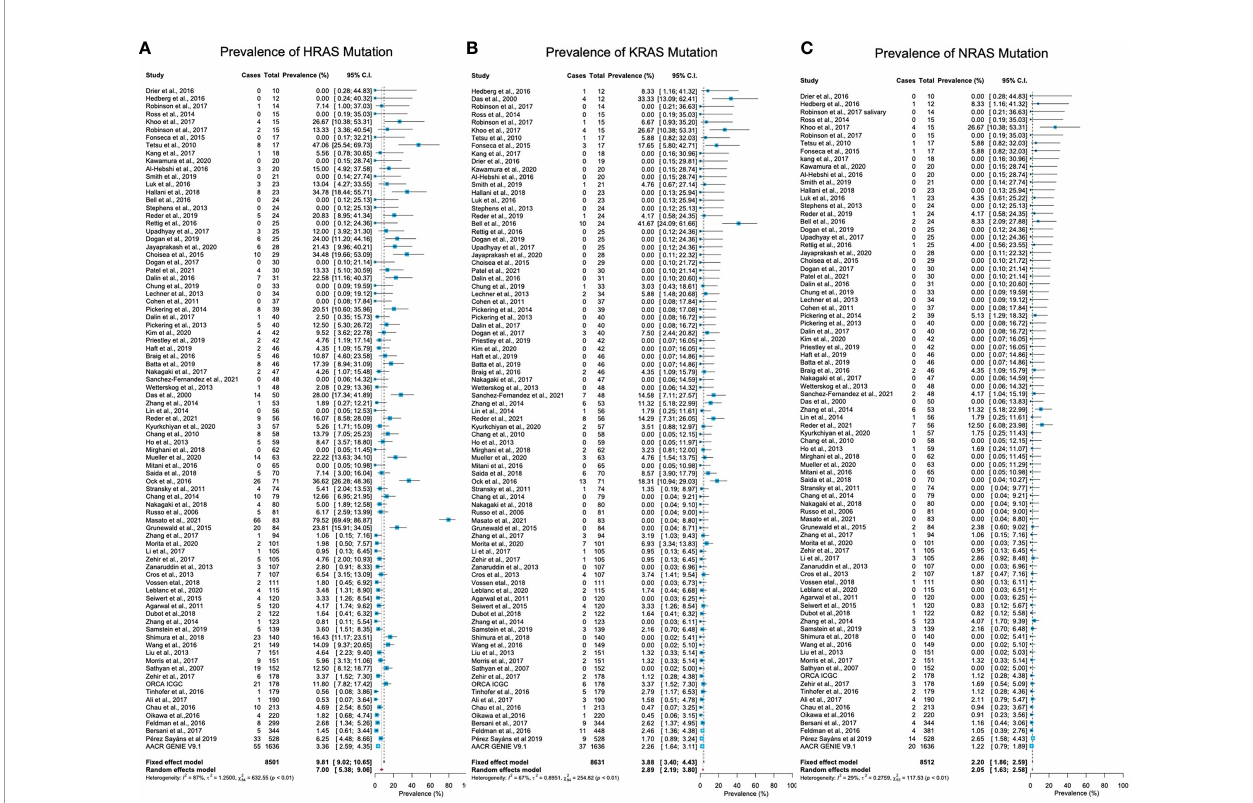
FIGURE 2 | Prevalence of RAS mutations in head and neck cancer. (A) The prevalence of HRAS mutations is 7% (95% CI, 5.38-9.06, p <0.01, I 2 = 87%). (B) The prevalence of KRAS mutations is 2.89% (95% CI, 2.19-3.80, p <0.0.1, I 2 = 67%). (C) The prevalence of NRAS mutations is 2.20% (95% CI, 1.86-2.59, p <0.01, I 2 = 29%). CI: Con fi dence interval. I 2 : Inconsistency